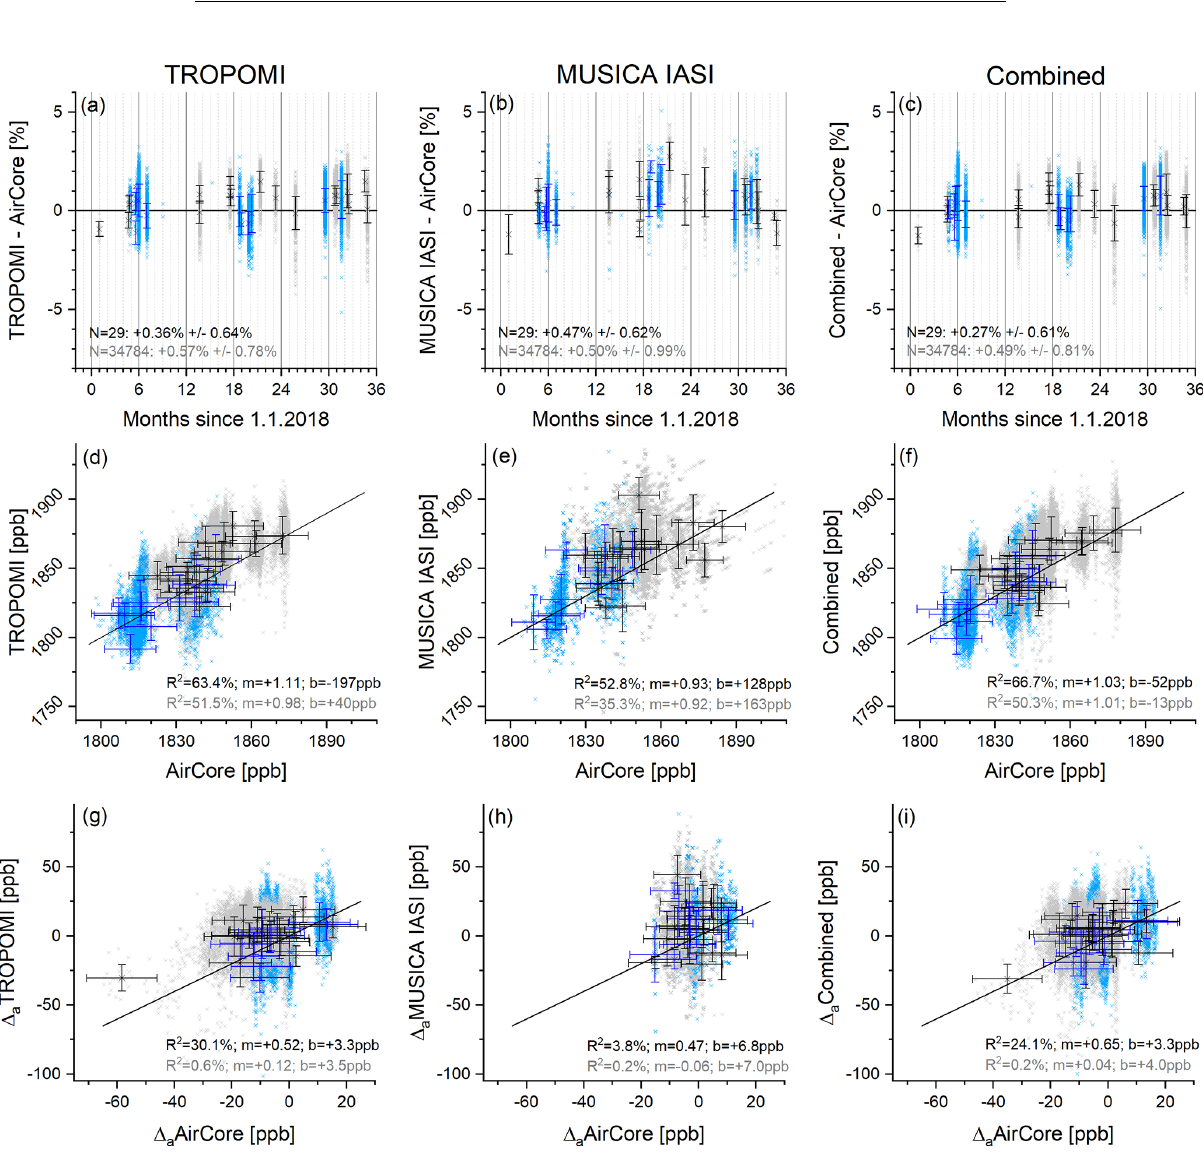
Figure 10. Comparison of the different satellite XCH 4 products with adjusted AirCore XCH 4 measured at Trainou (black) and Sodankylä (blue). Data for all individual coincidences are shown in the background as pale crosses, and daily averages are depicted as crosses with error bars (daily means are only calculated if there are at least three observations per day, which is the case on 29d of the total 31d with AirCore observations). (a–c) Time series of the differences (error bars represent the daily 1 σ standard deviation of the difference). (d–f) Correlation between AirCore and satellite data (the black line is the one-to-one diagonal, and the x -axis error bars represent the mean uncertainty estimated for the AirCore data – according to Eq. (F3) – and y -axis error bars the daily 1 σ standard deviation of the satellite data, respectively). (g–i) Correlation between the a priori free AirCore and satellite data (error bars as in d–f ). The inserted text reports median and scatter (hIPR68.2; a–c ) and the coefficients of determination, the slope, and the intercept of the robust linear regression model ( R 2 , m , and b ; d–i ). Black and grey fonts represent the values for the daily mean data and for data from all individual collocations,